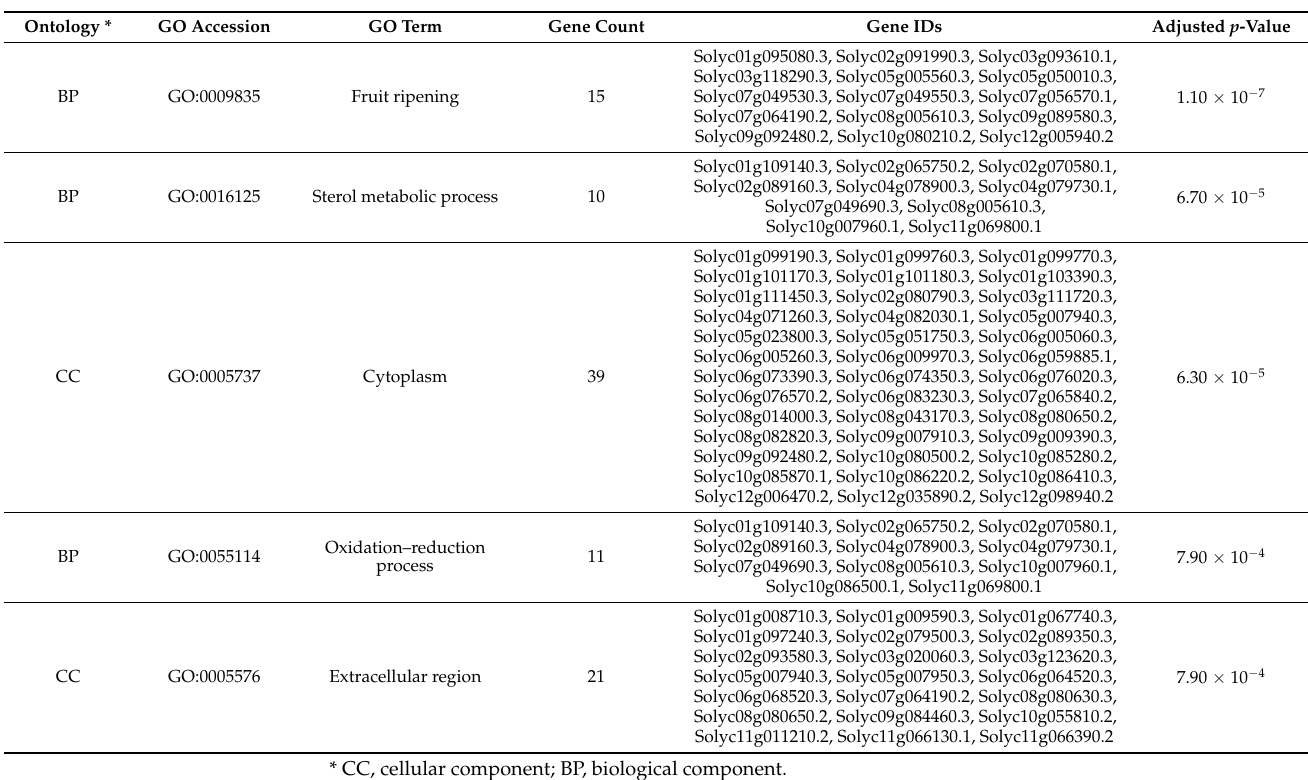
Table 5. Top five gene ontology (GO) terms enriched in SGR1-related differentially expressed genes (DEGs).